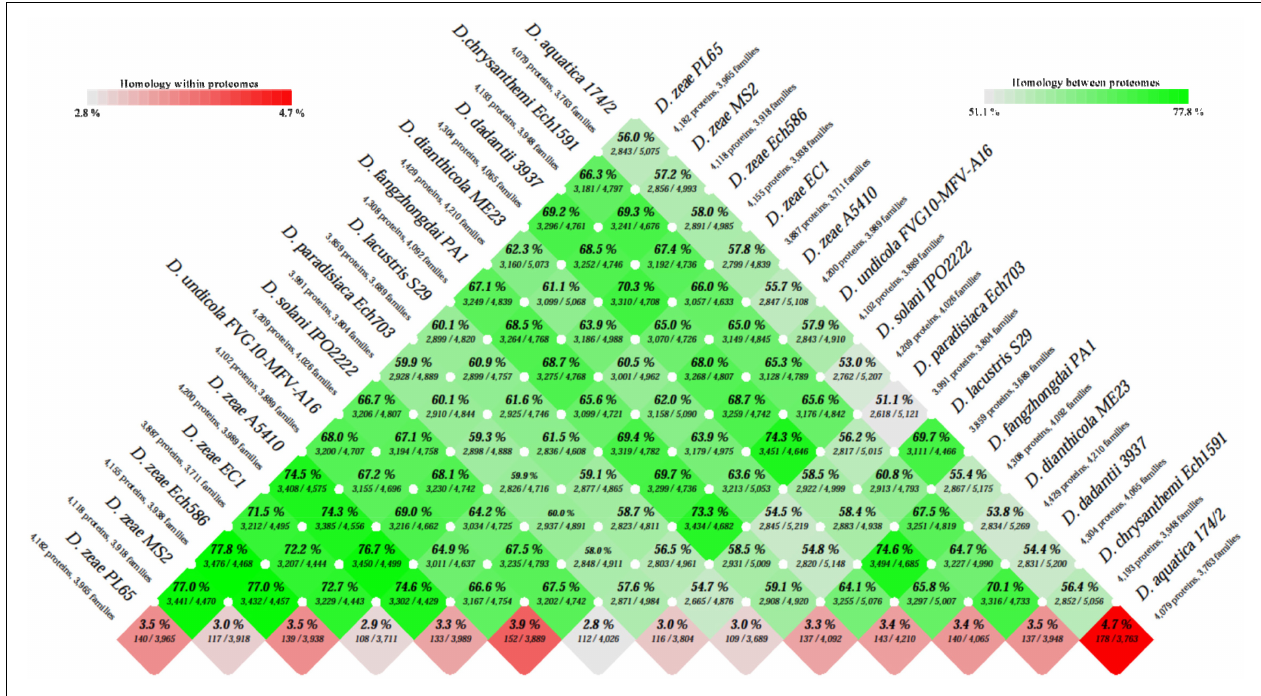
FIGURE 3 | Basic Local Alignment Search Tool (BLAST) matrix between and within the total proteomes of Dickeya genus. A pairwise protein comparison was performed using BLAST. All protein-coding sequences were compared with each other across the genomes. The BLAST hit was considered as significant when 50% of the alignment showed identical matches and if the coverage of an alignment was at least 50%. The color scale intensity from dark green to light green highlights a decrease in the degree of homology between the proteomes, whereas the color scale from dark red to light red shows decreasing homologous hits within the proteome